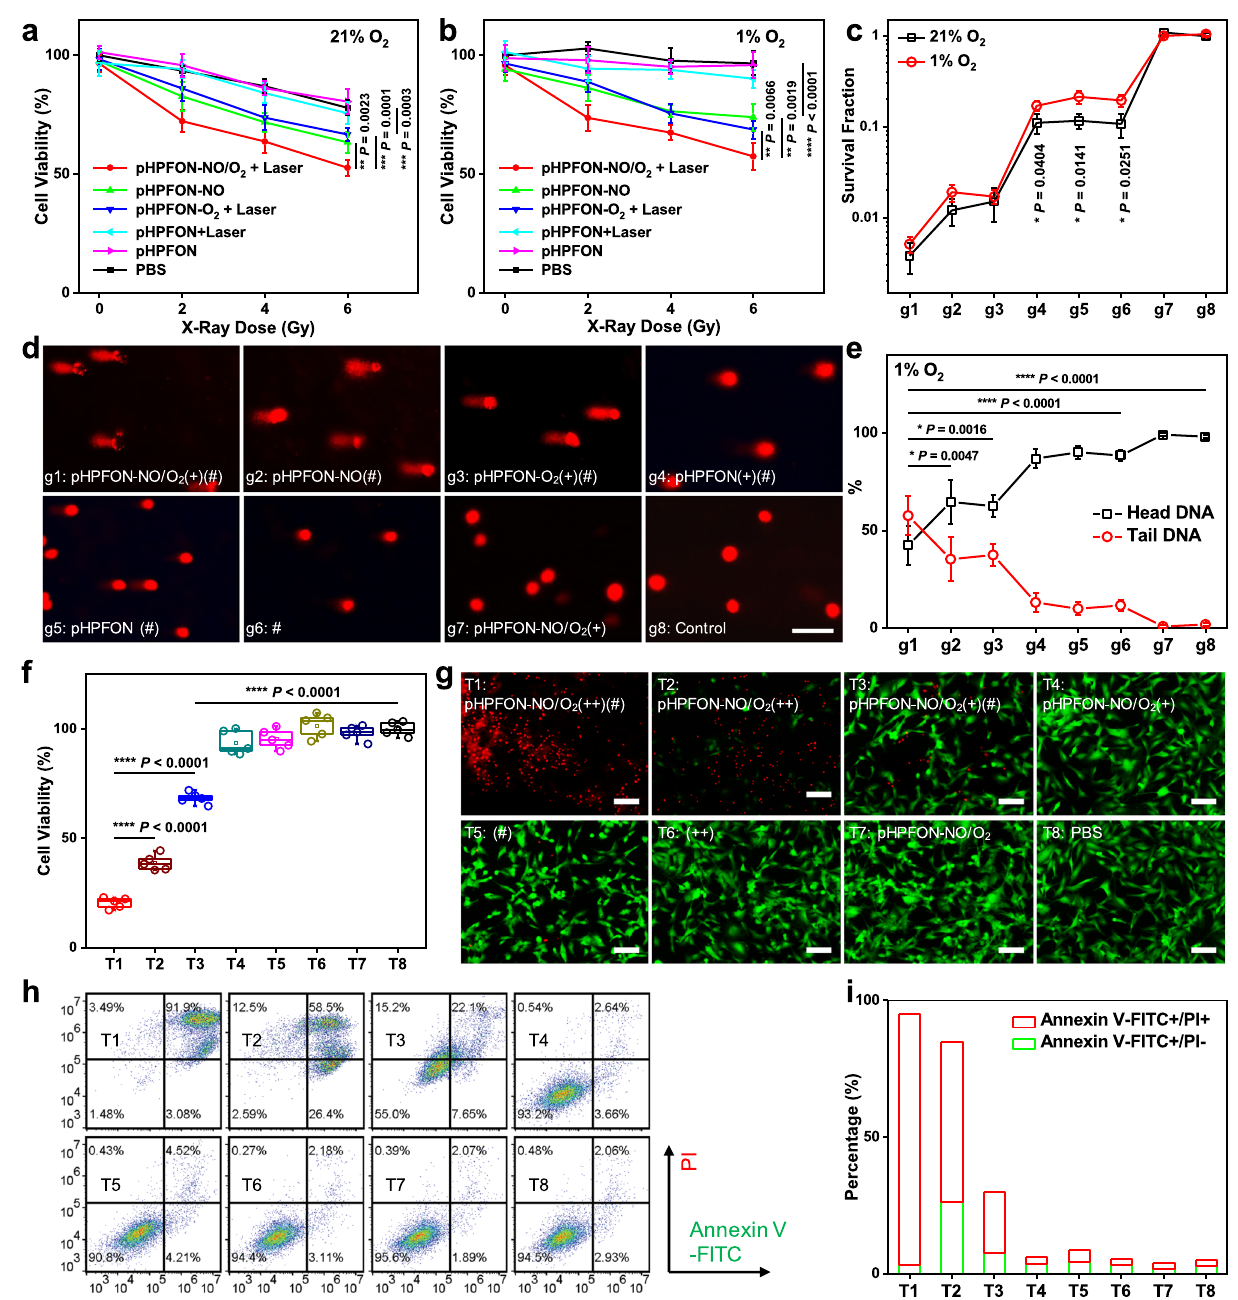
Fig. 5 In vitro radiotherapy. a – e NO and/or O 2 -boosted radiotherapy. a , b Cell viabilities of a normoxic (21% O 2 ) and b hypoxic (1% O 2 ) U87MG cells subjected to different nanoparticle treatments, following by an X-ray irradiation at various doses (0, 2, 4, 6 Gy). In the groups with laser irradiation, the laser (808 nm) was applied after 24 h of incubation at a dosage of 1 W/cm 2 for 3 min. n = 5 biologically independent samples per group. c Survival fraction determined by colony formation assays in both normoxic and hypoxic U87MG cells after different treatments. n = 3 biologically independent samples per group. d Fluorescent DNA-stained images by comet assays in hypoxic U87MG cells after different treatments. Scale bar, 50 μ m. Experiments were performed three times with similar results. e Quanti fi cation of DNA damage ( n = 6 independent experiments) according to the images in d . For c – e , groups g1 – g8: g1, pHPFON-NO/O 2 + Laser + X-ray; g2, pHPFON-NO + X-ray; g3, pHPFON-O 2 + Laser + X-ray; g4, pHPFON + Laser + X-ray; g5, pHPFON + X- ray; g6, X-ray; g7, pHPFON-NO/O 2 + Laser; g8, PBS. Laser (808 nm) was applied after 24 h of incubation with nanoparticles at 1 W/cm 2 for 3 min. X-ray was applied after the laser irradiation at a dose of 4 Gy. f – i In vitro synergistic photothermal and radiotherapy. f MTT assays ( n = 5 biologically independent samples). g Live and dead assays ( n = 3 biologically independent samples, with similar results). Green, Calcein-AM, live cells. Red, ethidium homodimer-1 (Eth-1), dead cells. Scale bar, 100 µ m. h Flow cytometry analysis ( n = 2 independent experiments, with similar results). i Quantitative analysis according to h on cells after different treatments. For f – i , groups T1 – T8: T1, pHPFON-NO/O 2 ( ++ )(#); T2, pHPFON-NO/O 2 ( ++ ); T3, pHPFON-NO/O 2 ( + )(#); T4, pHPFON-NO/O 2 ( + ); T5, (#); T6, ( ++ ); T7, pHPFON-NO/O 2 ; and T8, PBS. ( ++ ) stands for 808-nm laser irradiation at 1 W/cm 2 for 5 min. ( + ) stands for 808-nm laser irradiation at 1 W/cm 2 for 3 min. (#) stands for a 4-Gy X-ray irradiation. Laser was applied after 24 h of incubation with nanoparticles and X- ray was applied after the laser irradiation, if applicable. Data are presented as mean ± s.d. Two-tailed Student ’ s t -test. * P < 0.05. ** P < 0.01. *** P < 0.001. **** P < 0.0001. NATURE COMMUNICATIONS| (2021) 12:523 |https://doi.org/10.1038/s41467-020-20860-3|www.nature.com/naturecommunications